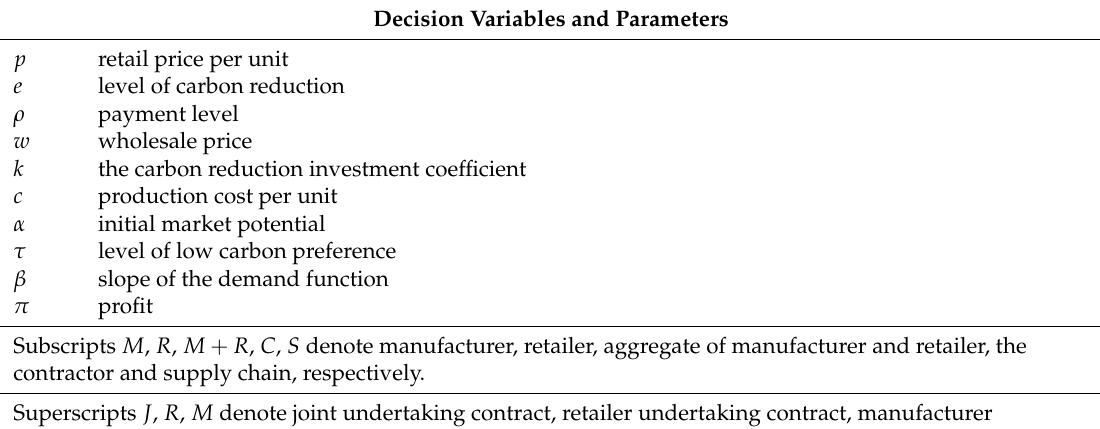
Table A1. Decision Variables and Parameters Used in the